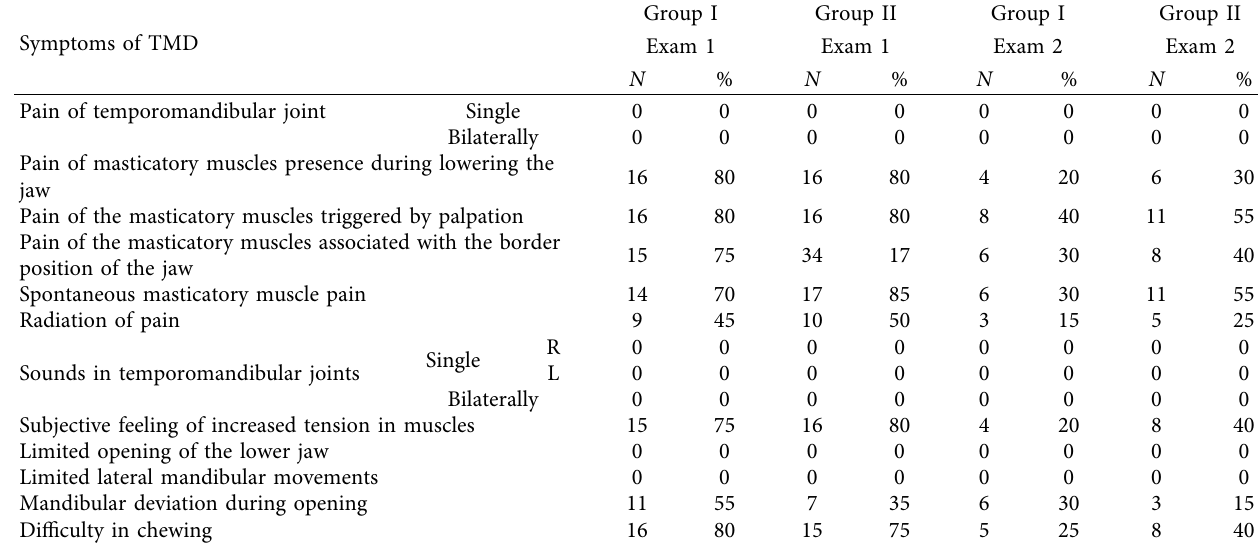
Table 1: Some symptoms of TMD obtained during I and II clinical examination of the stomatognathic system (axis I and II) conducted in both groups.